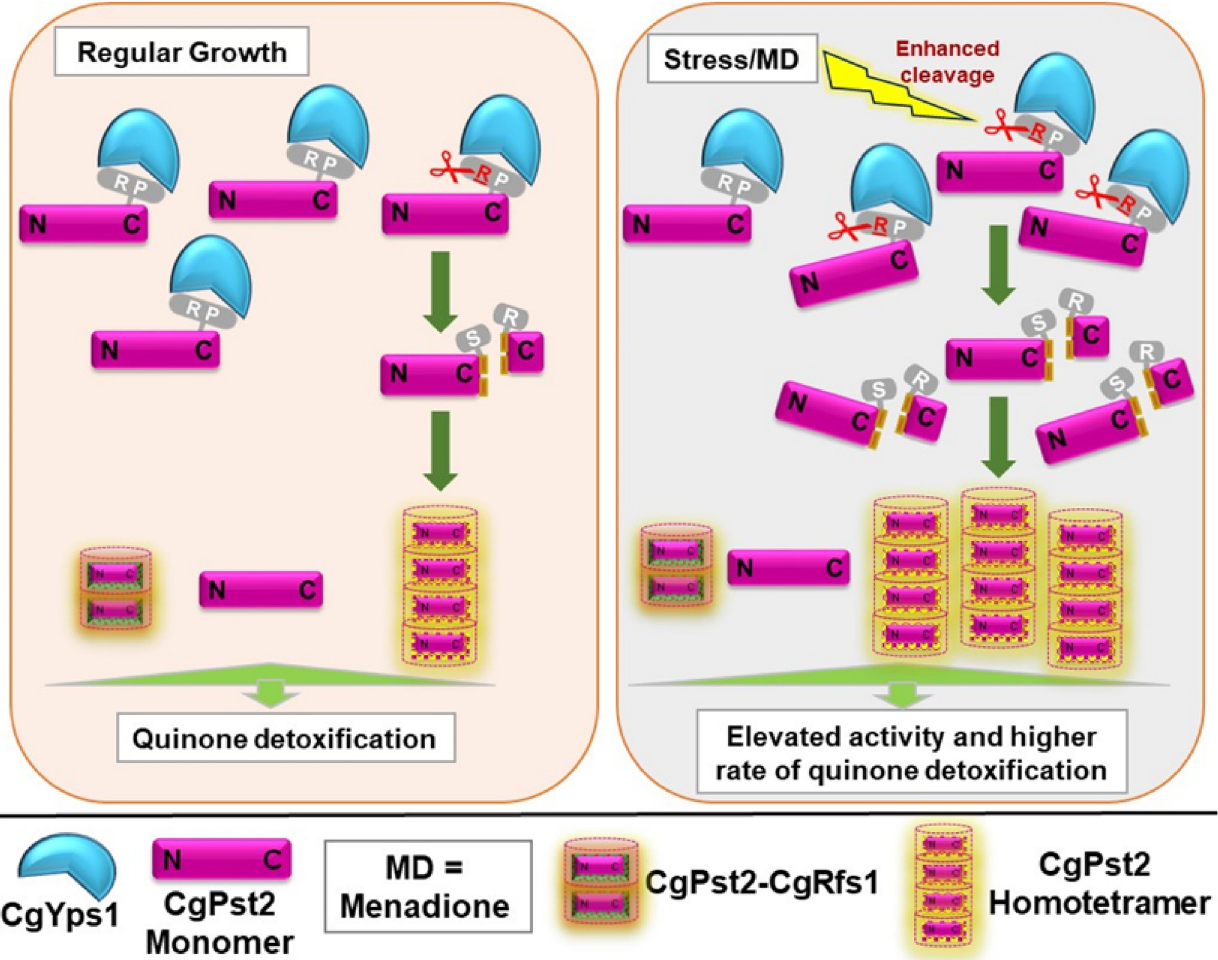
Fig 7. A schematic summarizing key findings of the study. Arginine-174 (R) and Proline-176 (P) residues of CgPst2 are predicted to interact with CgYps1 at the plasma membrane, and CgYps1 processes R174 residue in the C-terminus of CgPst2. This cleavage, which is elevated upon menadione treatment, leads to removal of the C-terminal domain, resulting in CgPst2 homo-tetramerization, higher activity and efficient quinone detoxification. Of note, the signal, that stimulates CgYps1-mediated cleavage of CgPst2, is not known. CgPst2 also interacts with CgRfs1, however, CgPst2-CgRfs1 association is not dependent on CgYps1, and occurs under both regular and MD treatment conditions. Altogether, CgPst2 functions are regulated at multiple levels, and CgYps1-mediated cleavage of CgPst2 may reflect one of many mechanisms controlling CgPst2